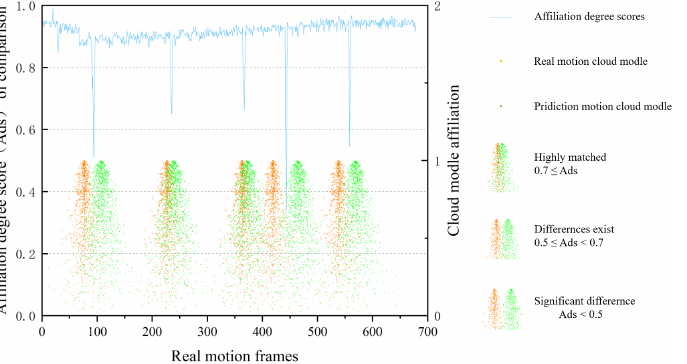
Figure 18. Segmentation results